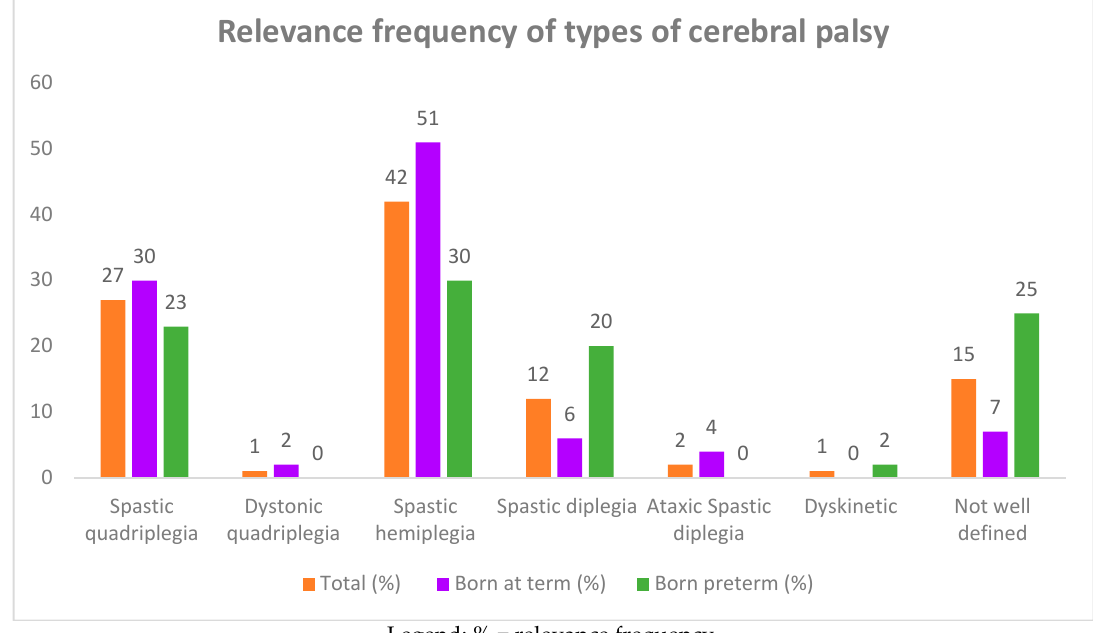
Legend: % = relevance frequency.